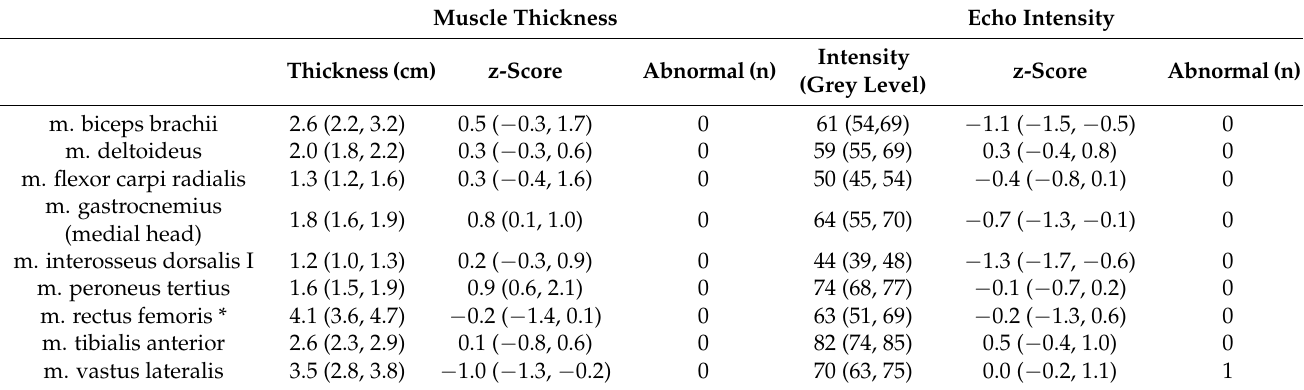
Table 4. Muscle ultrasound data of fourteen post-COVID-19 patients with peripheral muscle weakness. Muscle Thickness Echo